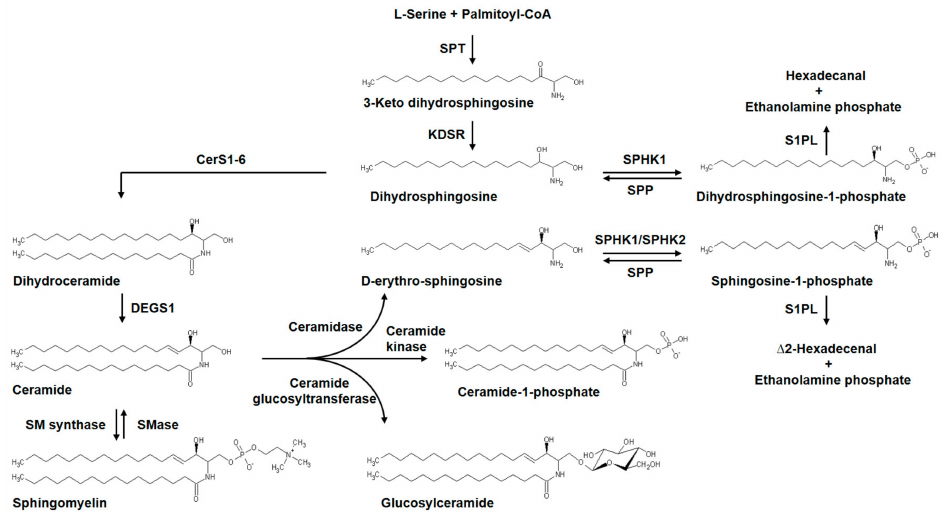
Figure 2. Sphingolipids implicated in pulmonary fibrosis, their structure, and metabolizing enzymes. An overview of de novo pathways of sphingolipid biosynthesis. Formation of the precursor 3-keto dihydrosphingosine from palmitoyl-CoA and L-serine catalyzed by SPT is the initial rate-limiting step, followed by generation of complex sphingolipids catalyzed by specific metabolic enzymes resulting in and glucosyl